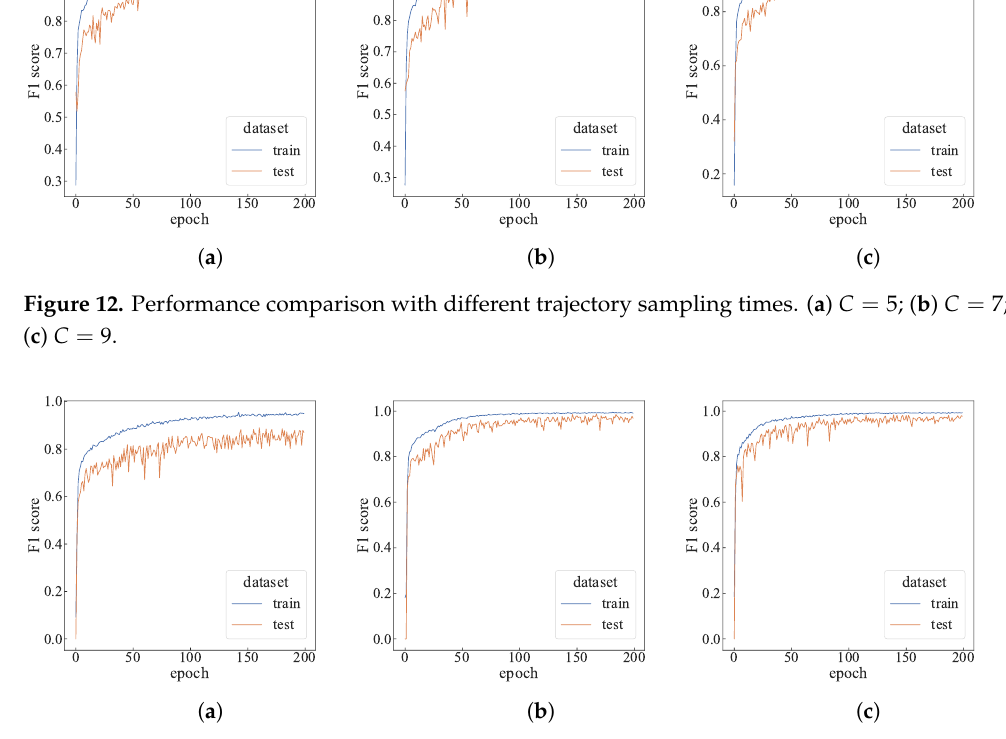
Figure 13. Performance comparison with different window sizes. ( a ) w = 10; ( b ) w = 30; ( c ) w =